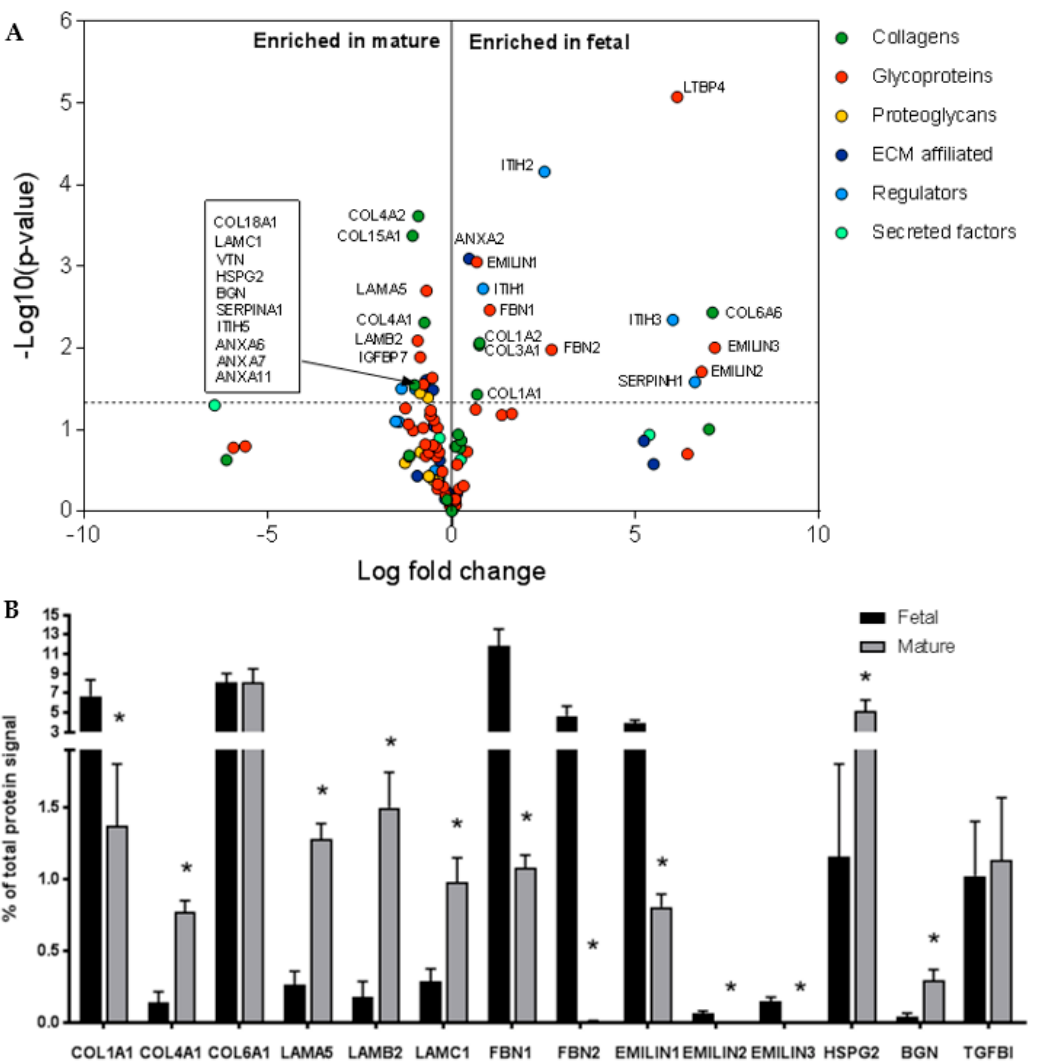
Figure 2. ( A ) Volcano plot represents the protein distribution of fetal and mature extracellular matrix (ECM) proteome fold-changes (x-axis, log fold-change) and significance (y-axis, − log p -value). Each circle represents a matrisome protein and each color a specific subset of the matrisome proteins. The horizontal line indicates p < 0.05. ( B ) Bar graphs shows examples of ECM proteins identified with LC-MS/MS. Each protein signal is the percentage of the total protein signal. Data are shown as mean ± SEM, N = 3, * p < 0.05.